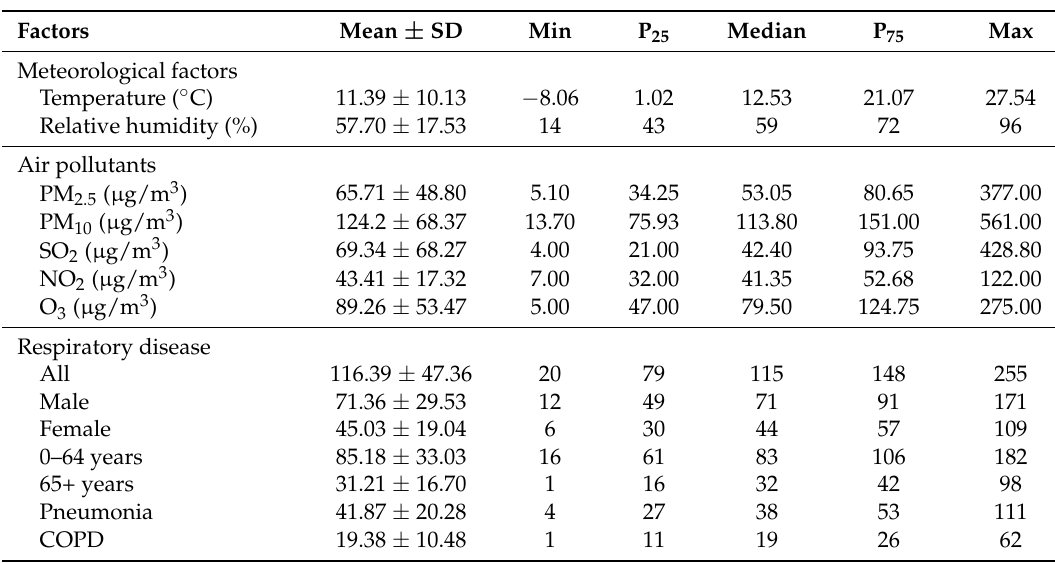
Figure 1. The spatial distributions of air monitoring sites and hospitals in Taiyuan, China. Table 1. Descriptive statistics for respiratory disease hospitalization, air pollutants and meteorological factors in Taiyuan, China, 2014 – 2017.